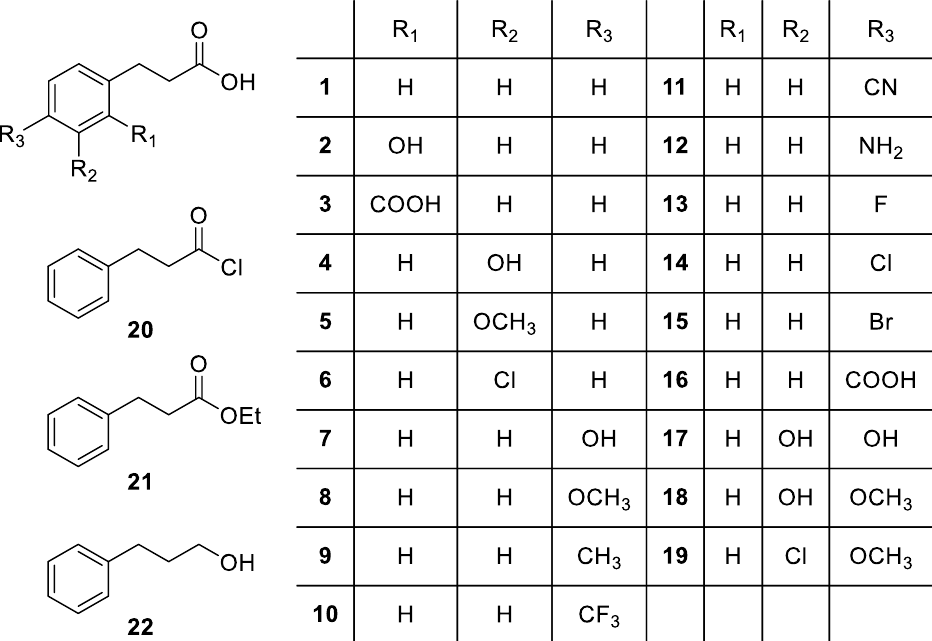
Figure 1. Summary of the structures of compounds 1 – 22 used in this study.